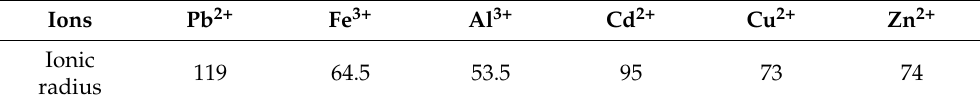
Table 5. Comparison of the physico-chemical properties of the cations.